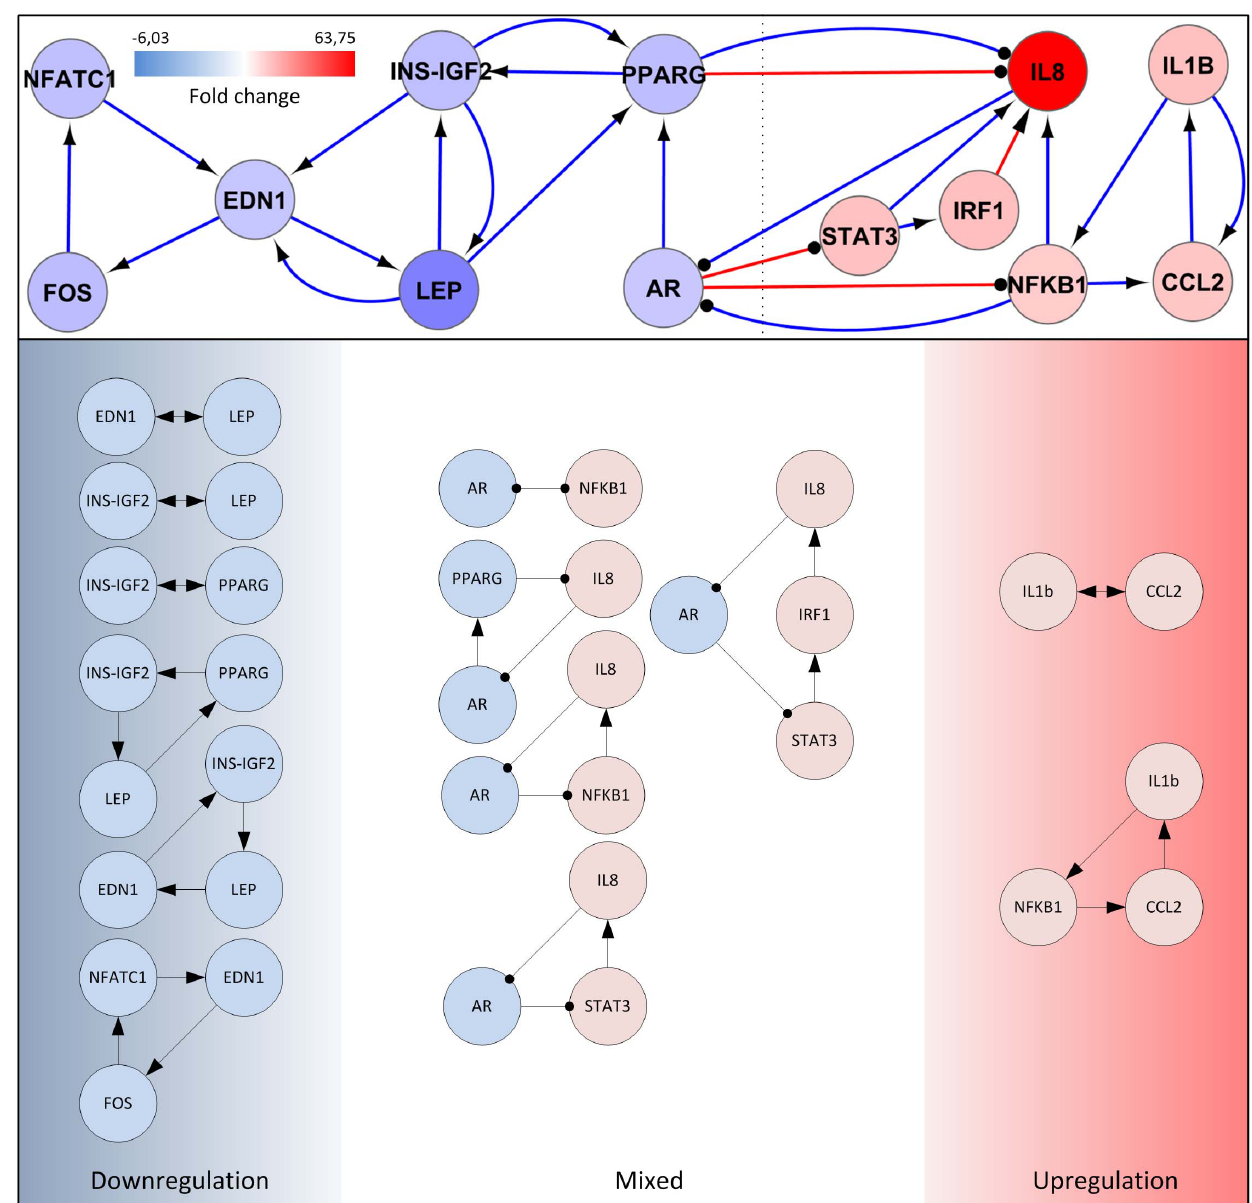
Figure 4. Positive feedback loops and the merged controller sub-network in lesional psoriatic skin. Individual positive feedback loops with 2, 3 or 4 nodes are shown. Node color is blue if the gene expression is decreased and red if increased. Merged controller sub-network is shown on the top. Node color is proportional with fold change. red line: gene regulatory interaction; blue line: protein-protein interaction; arrow-headed line: activation; bar-headed line: inhibition